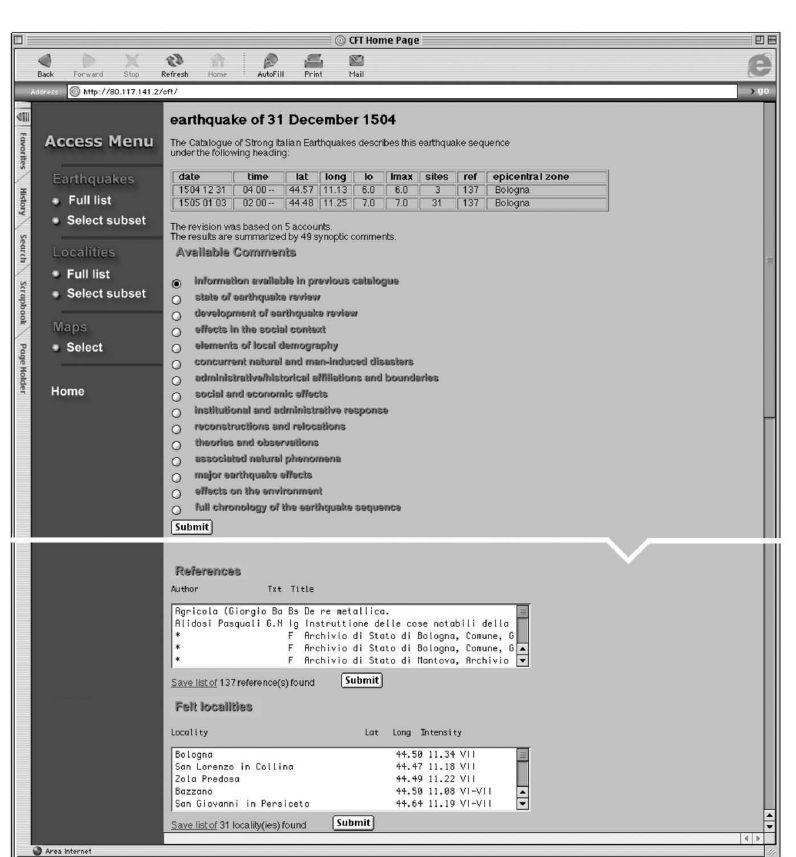
Fig. 2. CFTI query by